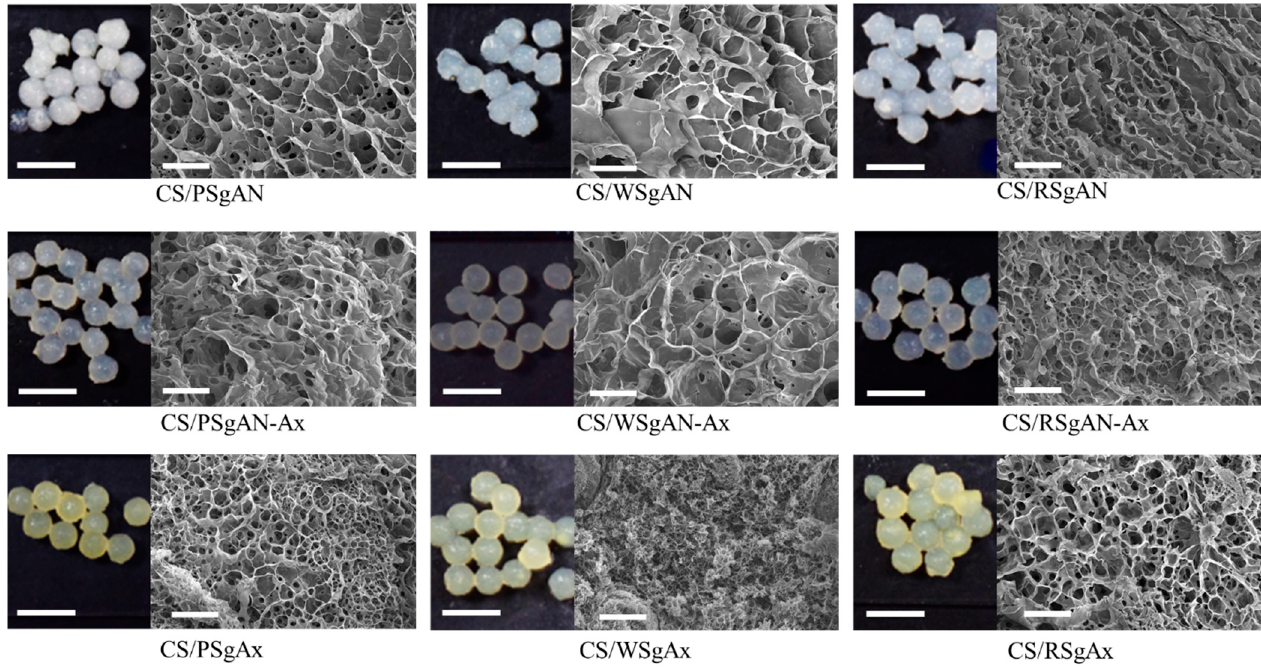
Figure 3. Optical (scale bar 5 mm) and SEM (scale bar 20 µm) images of composite beads.